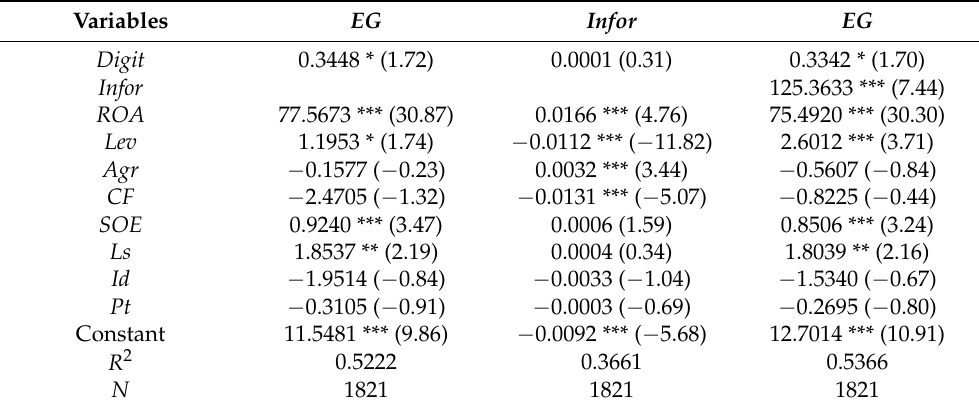
Table 10. Regression results of effects of accounting information comparability